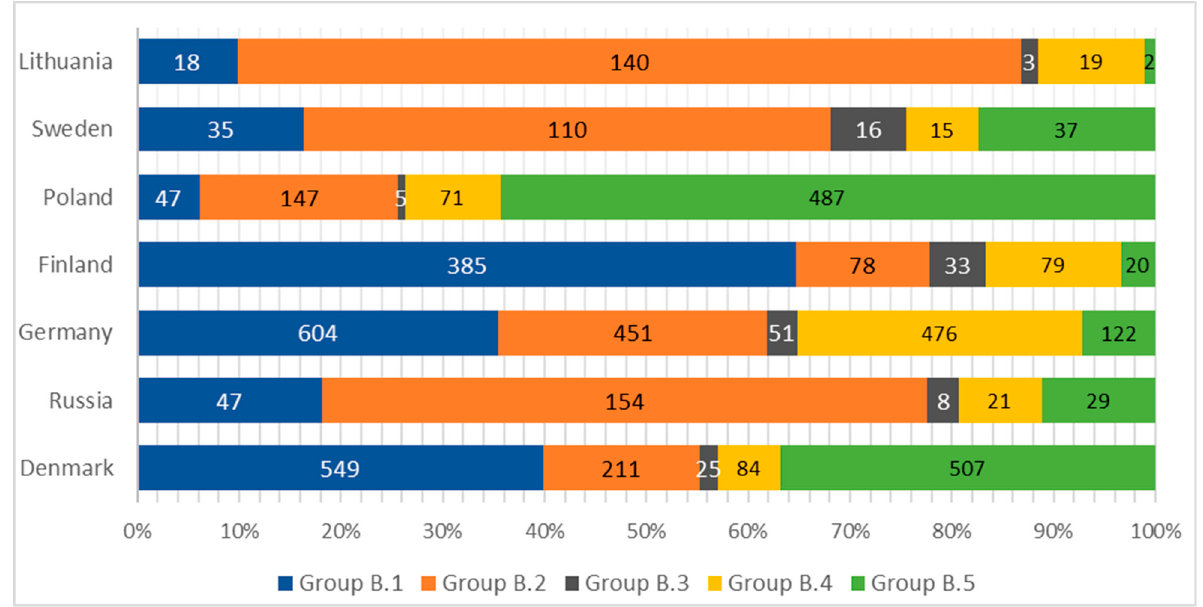
Figure 2. Distribution of categories of national Red Lists and Books according to groups B.1–B.5. Species with a more stringent category at the national level (group B.2) are most numerous in Lithuania (77%), Russia (59%), and Sweden (52%), while the lowest values are in Finland (13%) and Denmark